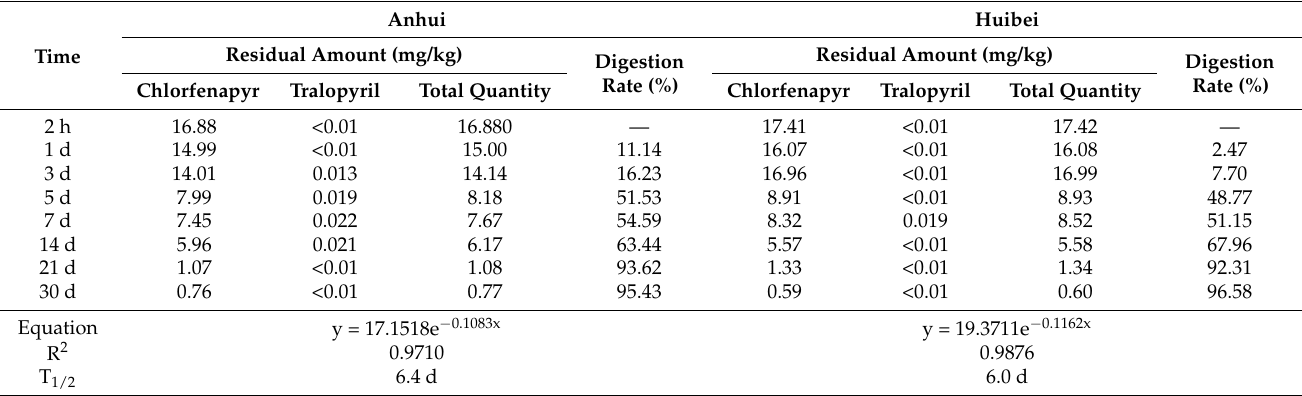
Table 2. Degradation of chlorfenapyr in radish leaf.